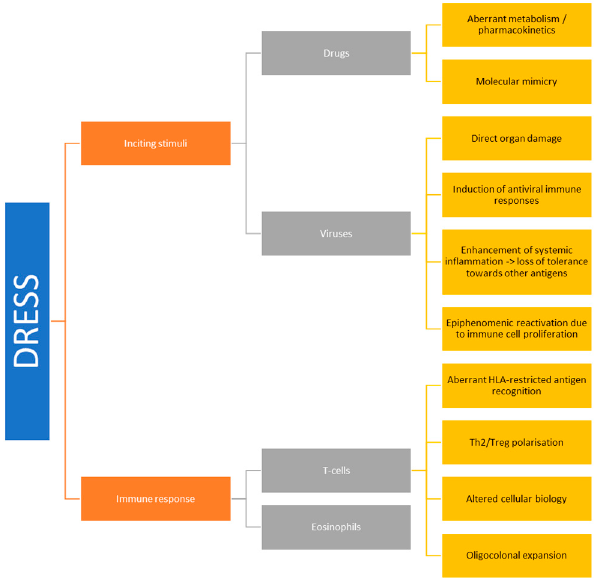
Figure 1. Simplified DRESS aetiopathogenesis. Flow-chart depicting the pathophysiological relationships among the main exogenous and host-related factors involved in the development of DRESS.